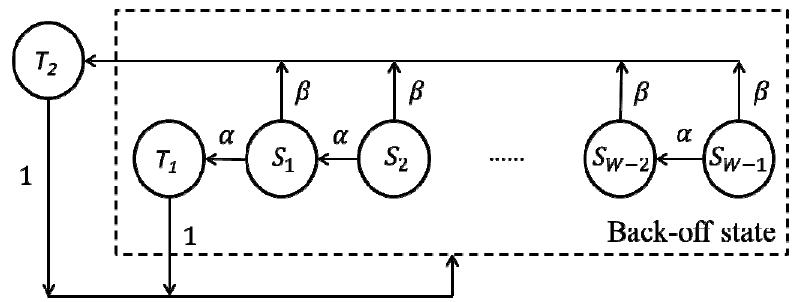
Figure 7. State transition diagram of the FD node in the network.